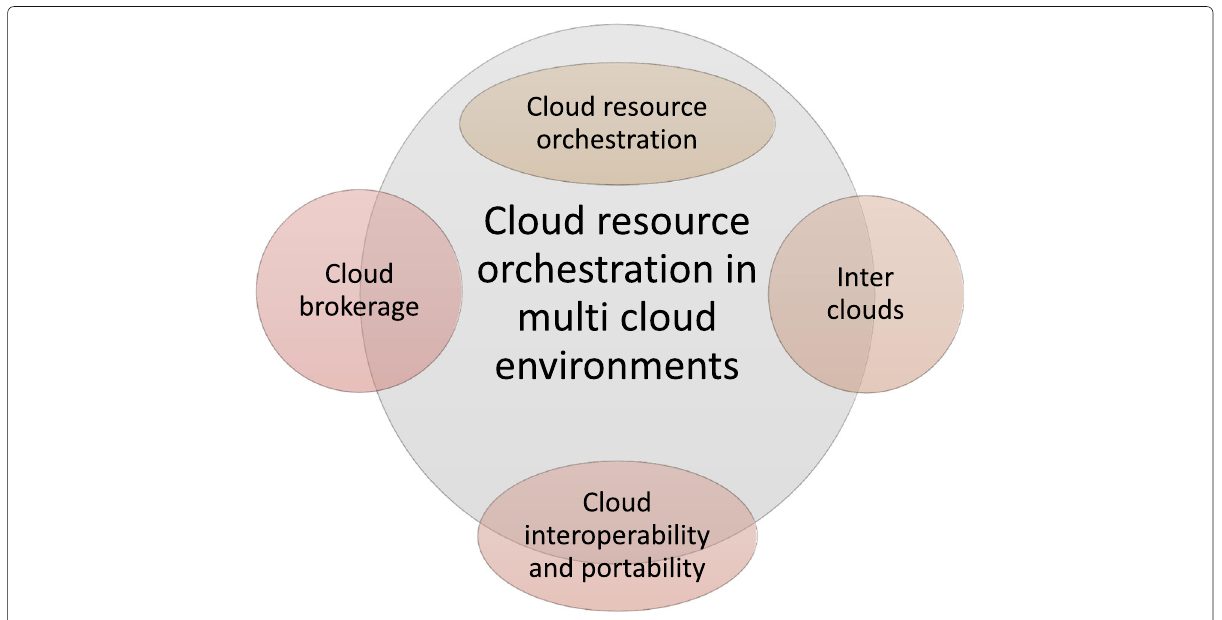
Fig. 2 Related research areas Cloud